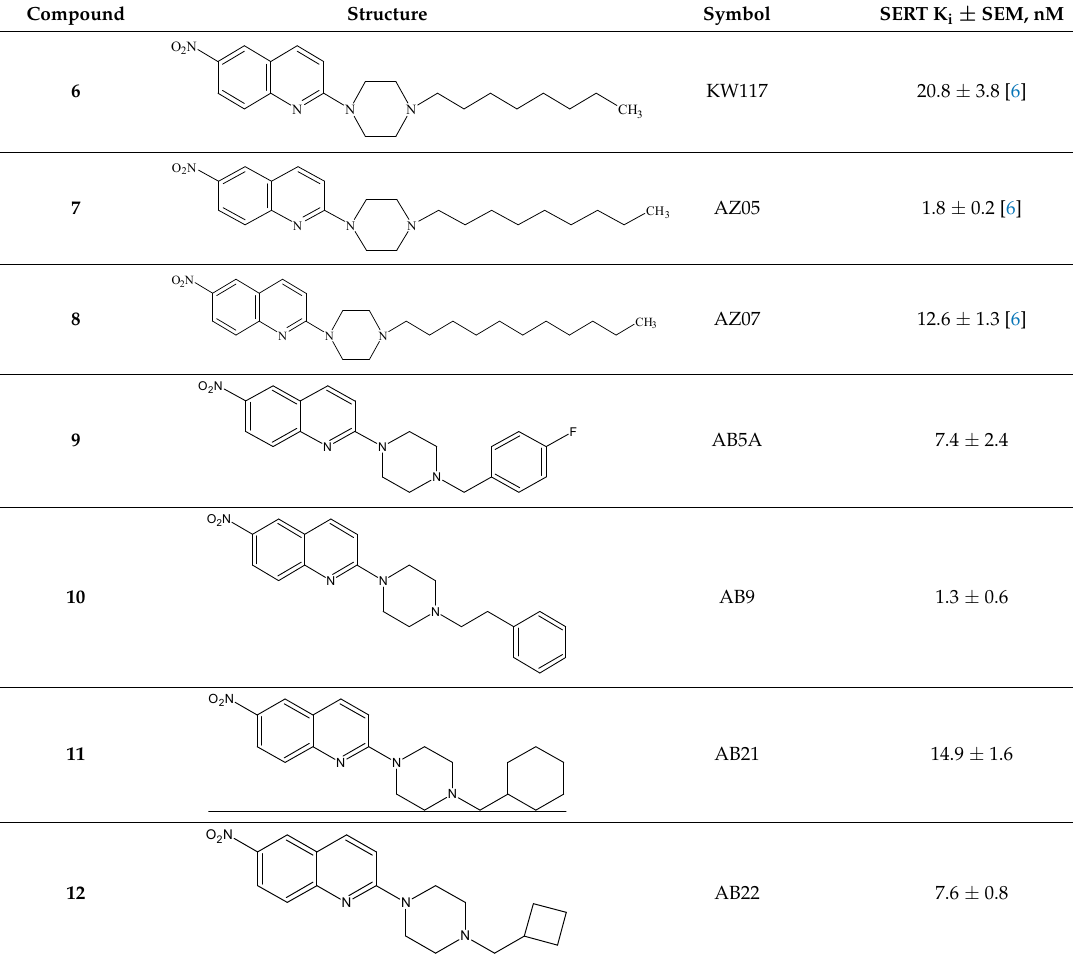
SEM — standard error of the mean